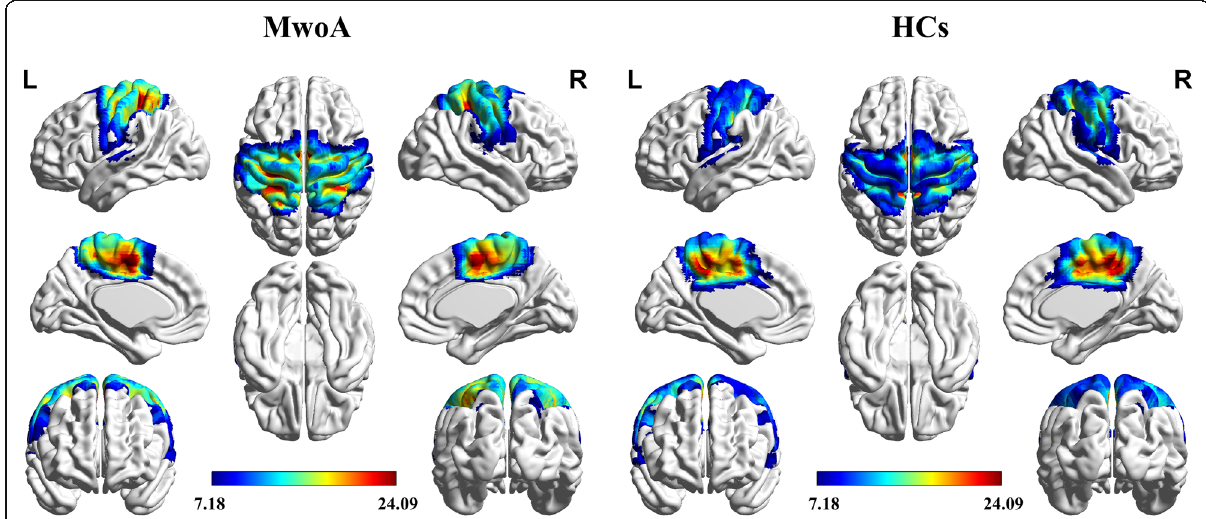
Fig. 1 Group-level sensorimotor network in migraineurs without aura (MwoA) and healthy controls (HCs). Significant thresholds were corrected by family-wise error correction ( p <